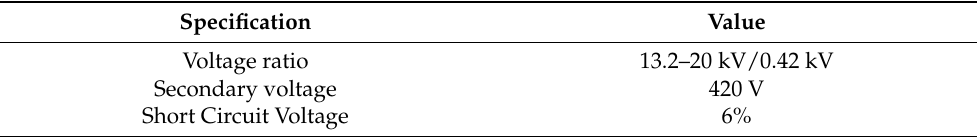
Table 1. Specifications for the substation in the LUCIA